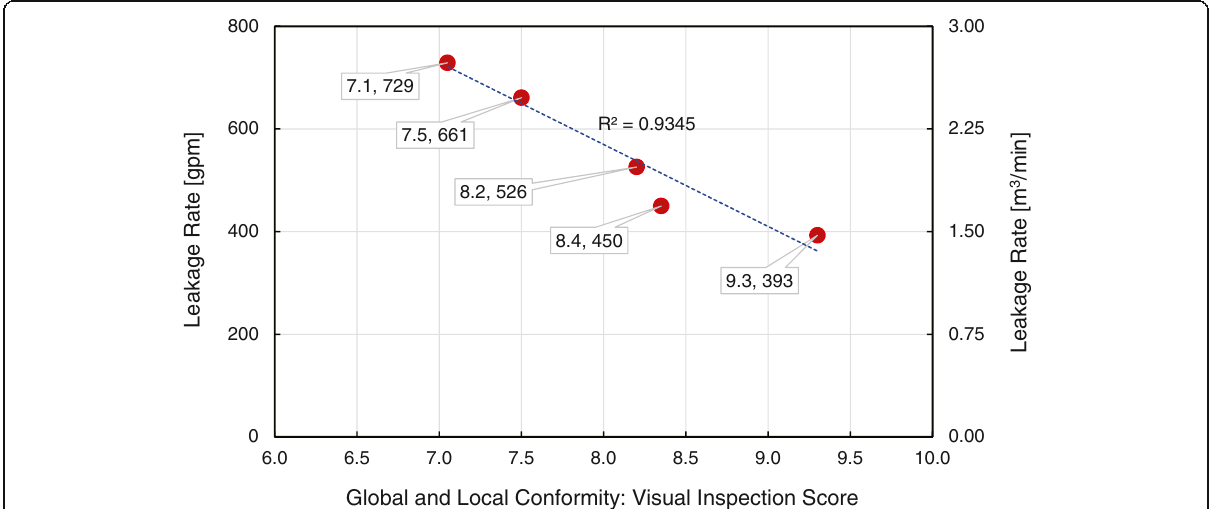
Fig. 17 Leakage rates vs. Inspection scores obtained from flooding simulations completed during Phase 2b and Phase 2b-ET. Scale range for scoring system min = 0 and max = 10 [69,